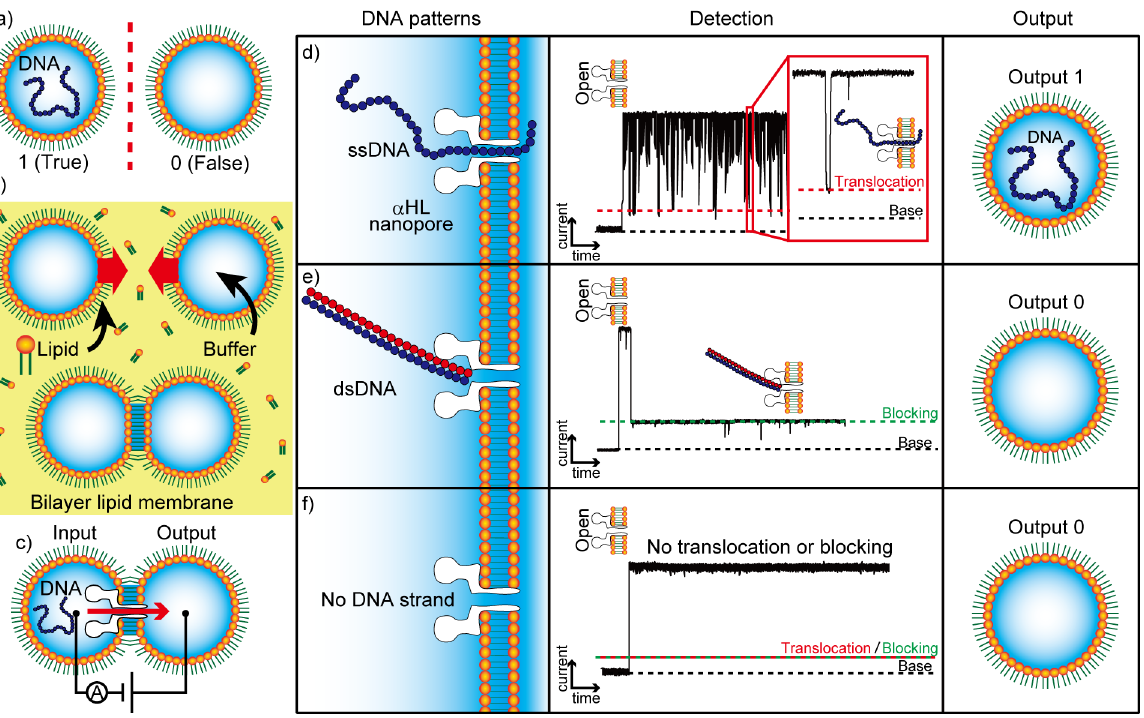
Fig 1. Droplet contact method (DCM) and the binary system based on DNA blocking and translocation. (a) Definition of the binary system based on the presence of DNA in an aqueous droplet coated with a lipid monolayer. (b) A schematic view of the bilayer lipid membrane (BLM) formed via DCM. (c) The system for DNA transfer among droplets by DNA translocation through α HL nanopores. (d – f) Electrical detection of DNA translocation and determination of the presence of DNA constructs in the droplet. (d) Output 1 (translocation): A single-stranded DNA (ssDNA) is translocated through an α HL nanopore with a short current blockade. (e) Output 0 (blocking): A double-stranded DNA (dsDNA) is not translocated through the α HL nanopore owing to its larger diameter, inducing a long current blockade. (f) Output 0 (No DNA strand): No DNA strand is present for translocation, and thus no current blockade is generated.